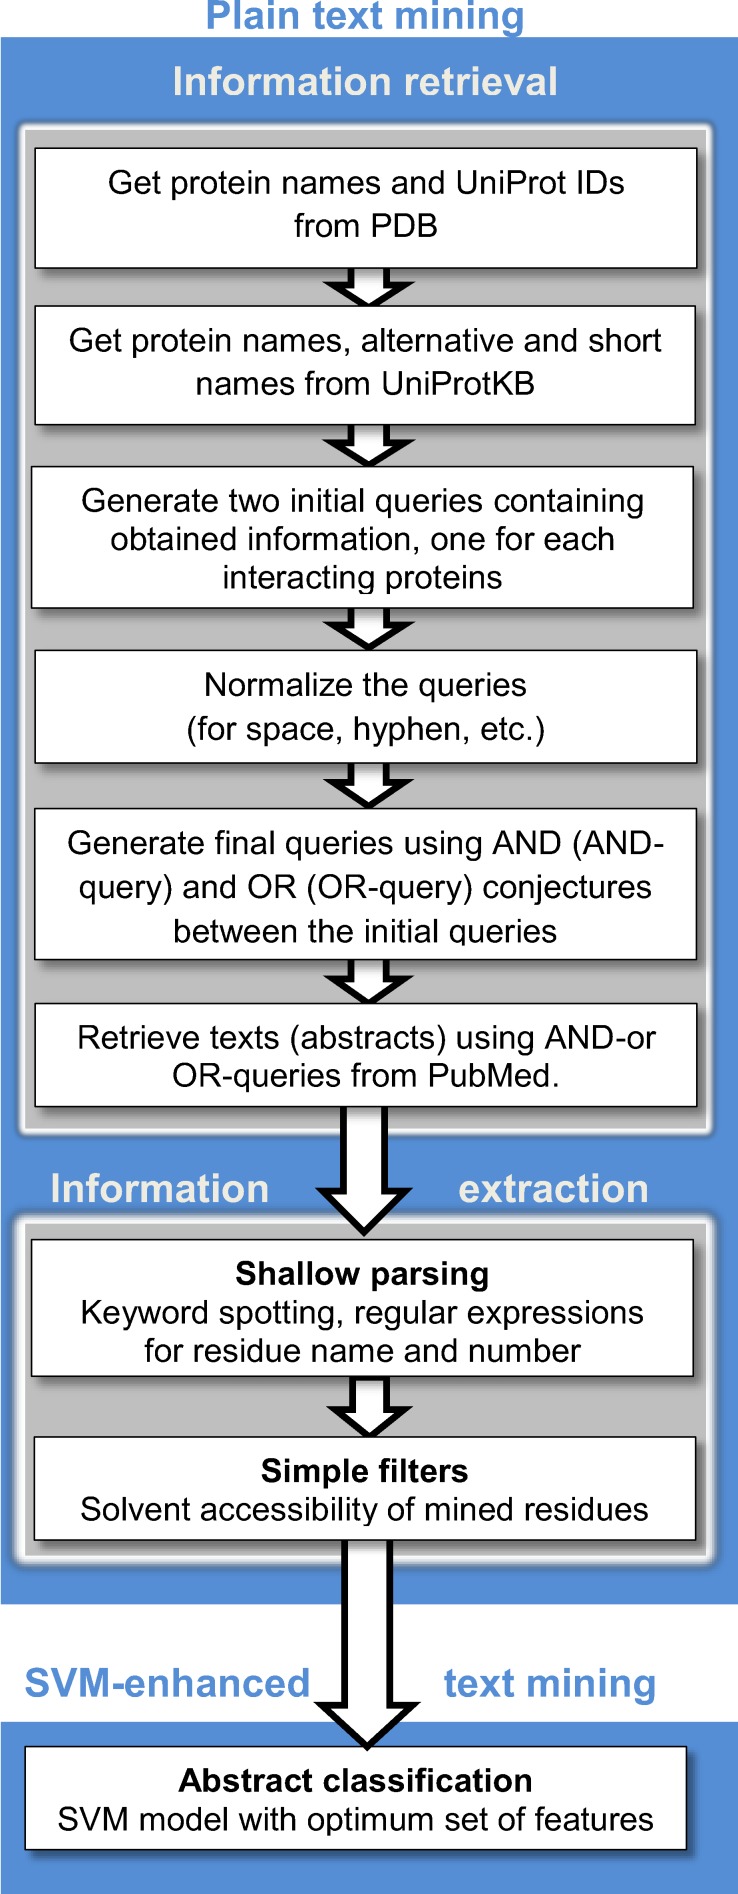
Flowchart of the text mining protocol.